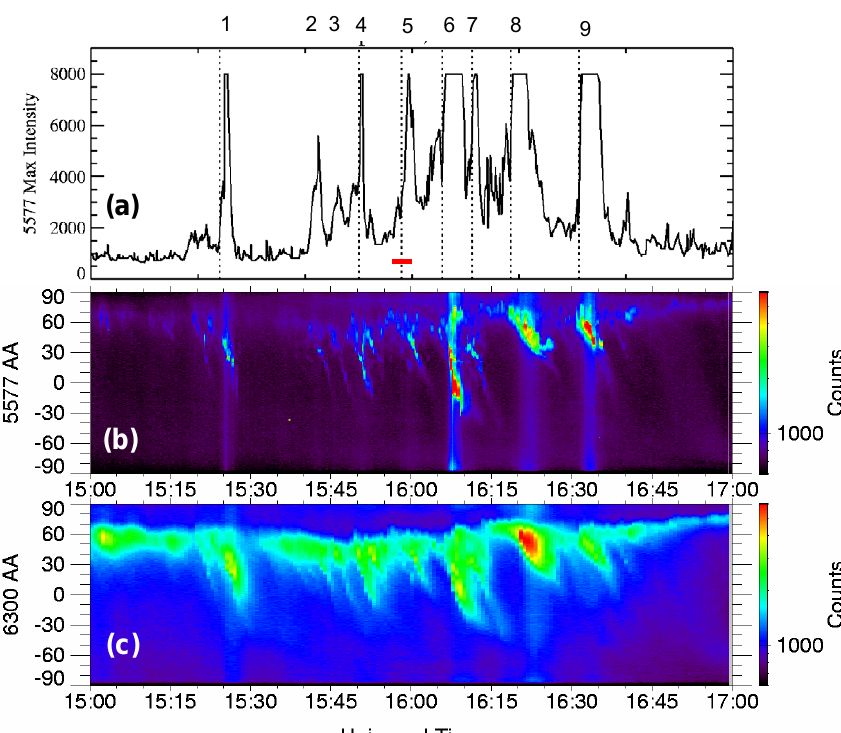
Fig. 6. (a) The maximum intensity of 557.7nm emissions in each of the all-sky images versus UT for the two hour interval. (b, c) Keograms, or meridian-scan plot versus time, extracted from the 557.7nm and 630.0nm all-sky images. Emission intensities in counts are color-coded on a zenith-angle versus UT plot. The most poleward reaches of scans are at the bottoms of the keograms. The red bar in (a) marks the interval of images in Fig. 5. Note that each peak in the maximum intensity corresponds to a PMAF in the